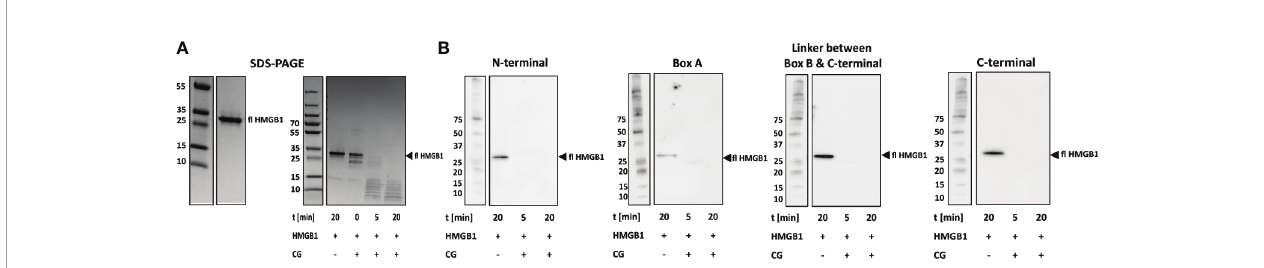
FIGURE 3 | CG rapidly degrades HMGB1. (A) Left panel: SDS-PAGE showing full length HMGB1. Right panel: SDS-PAGE showing the rapid degradation of HMGB1 by CG over time. (B) Western blotting with antibodies recognizing epitopes within the N-terminal, the Box A, the linker between Box B and C-terminal and within the C-terminal regions resulted in detection